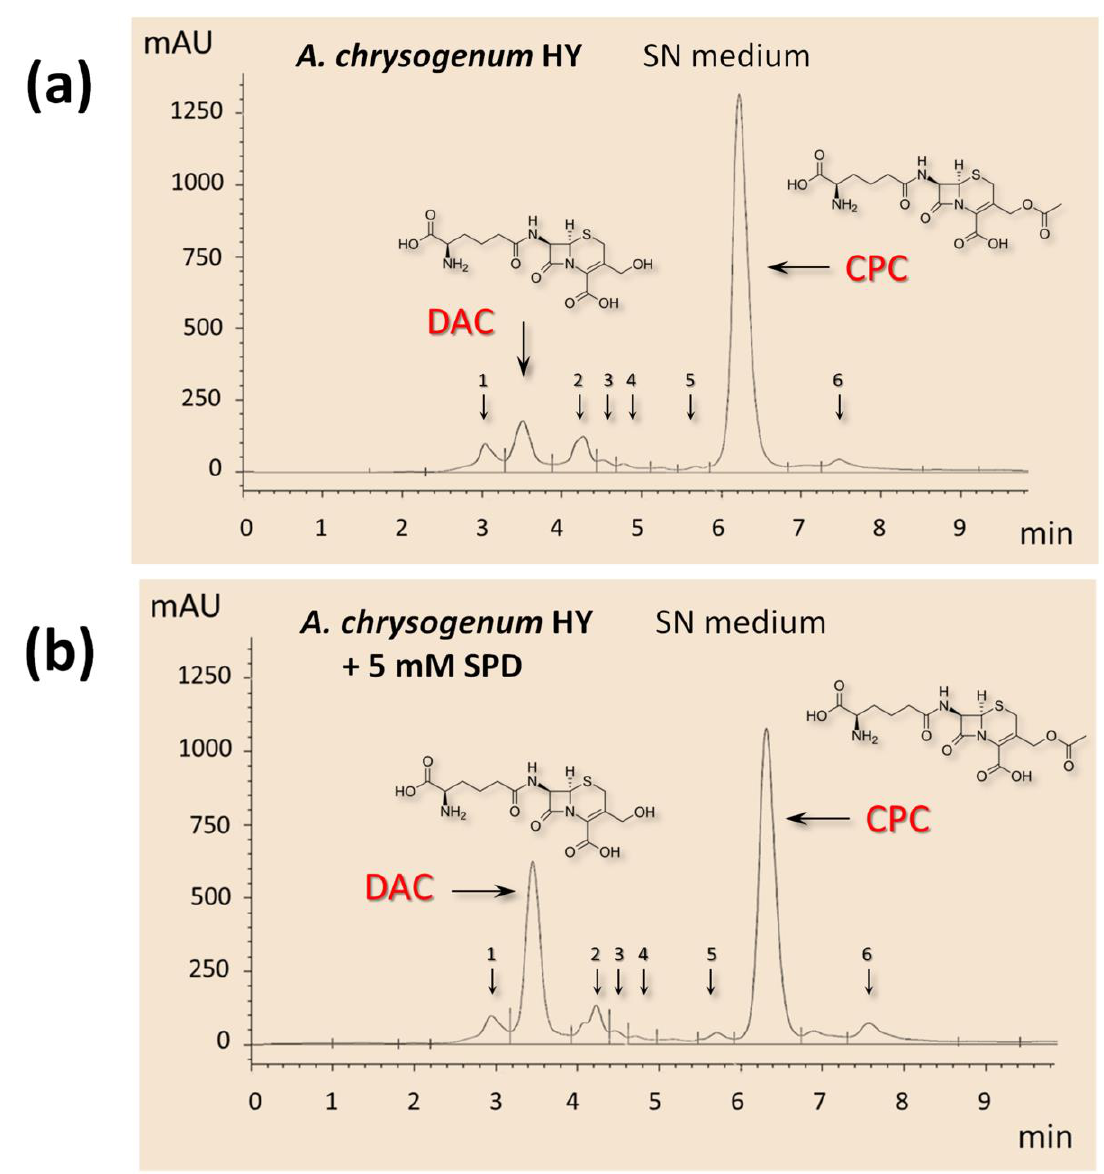
Figure 4. HPLC analysis of beta-lactam production of the A. chrysogenum high-yielding (HY) strain after 144 h of cultivation on synthetic (SN) medium: ( a ) without additives (control); ( b ) with 5 mM spermidine (SPD), added at the starting point of cultivation. Arrows show chromatographic peaks corresponding to deacetylcephalosporin C (DAC), cephalosporin C (CPC), and minor by-products.